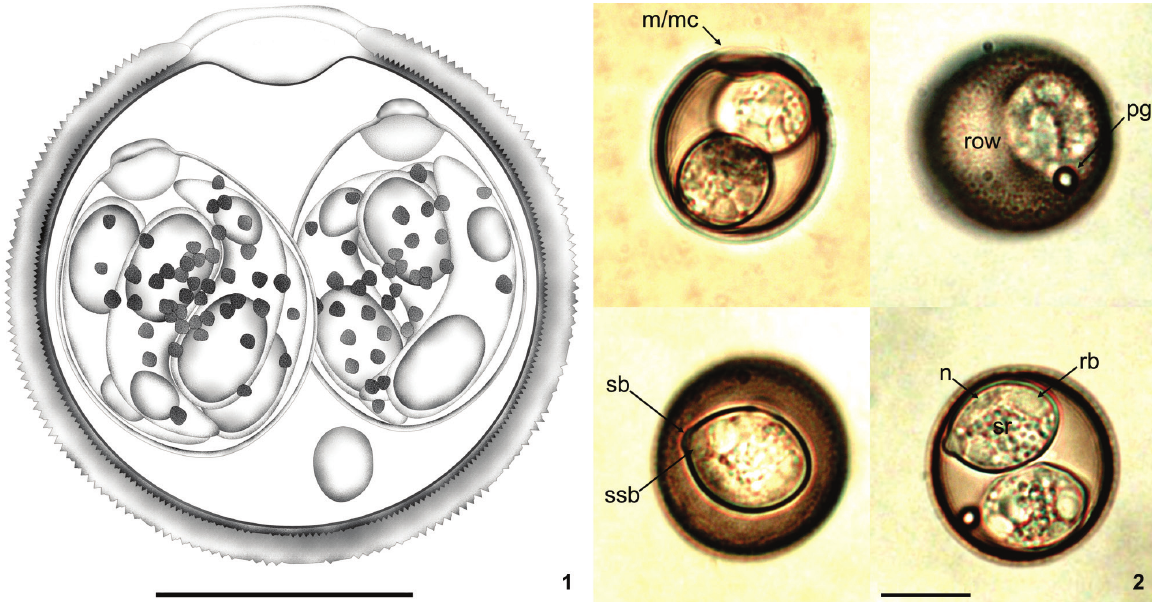
Figures 1–2. Sporulated oocysts of Isospora machadoae sp. nov. recovered from Turdus albicolis from Brazil: (1) line drawing; (2) photomi- crographs. Note the micropyle and micropyle cap (m/mc), nucleus (n), polar granule (pg), refractile body (rb), rough oocyst wall (row), Stieda (sb) and sub-Stieda bodies (ssb) and the sporocyst residuum (sr). Scale bar = 10 µm. Table 1. Comparative morphology of Isospora spp. recorded from Turdidae of the New